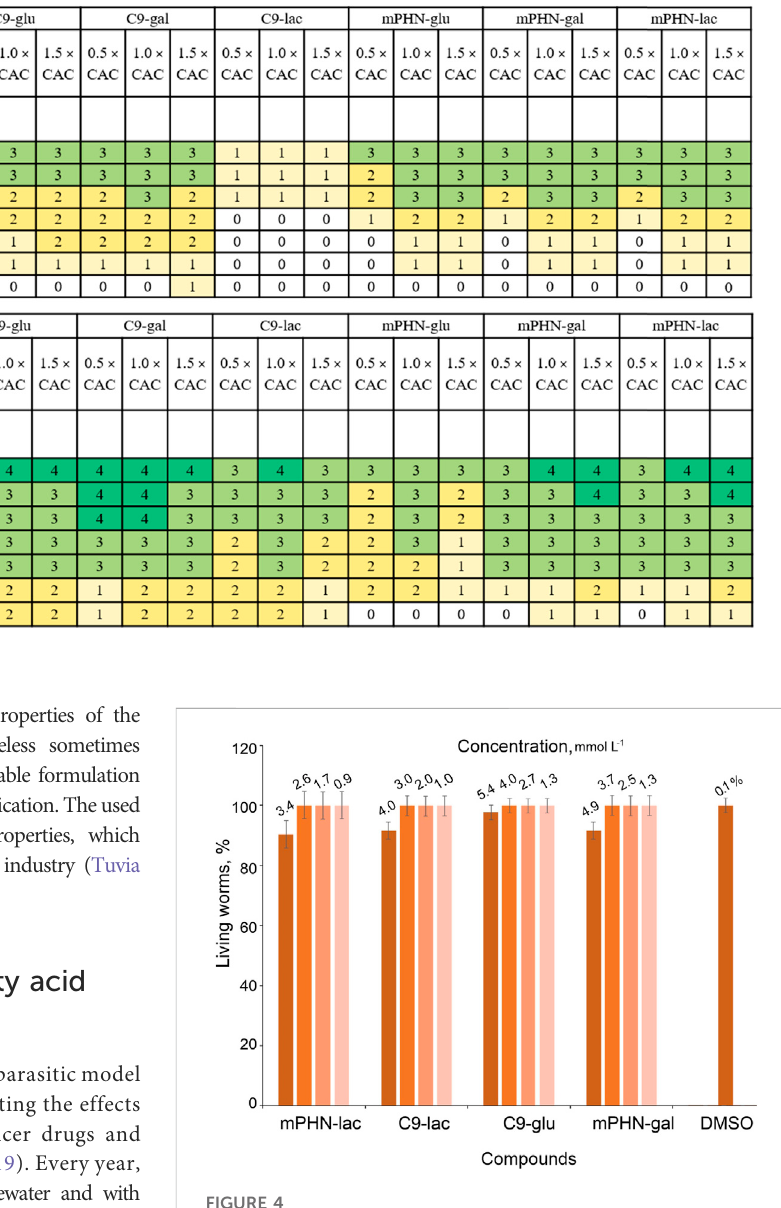
TABLE 3 Emulsion stability of two exemplary water/oil systems in time. Numbers-colors and their intensity is a scale referring to the intensity of a particular emulsion. Exemplaryphotos of the formedemulsions Supplementary Figure S2.a) Control- W/Osystems with noSFAEadditionb) squalene as oil phase with SFAEs as stabilizers